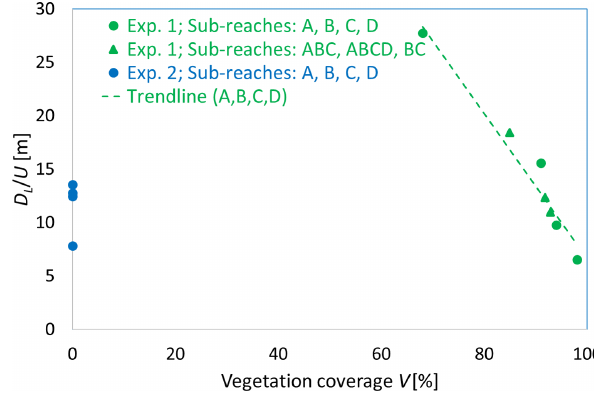
Figure 12. Longitudinal dispersion coefficient ( D L ) depending on the vegetation coverage ( V ) in fully vegetated conditions (Exp. 1).